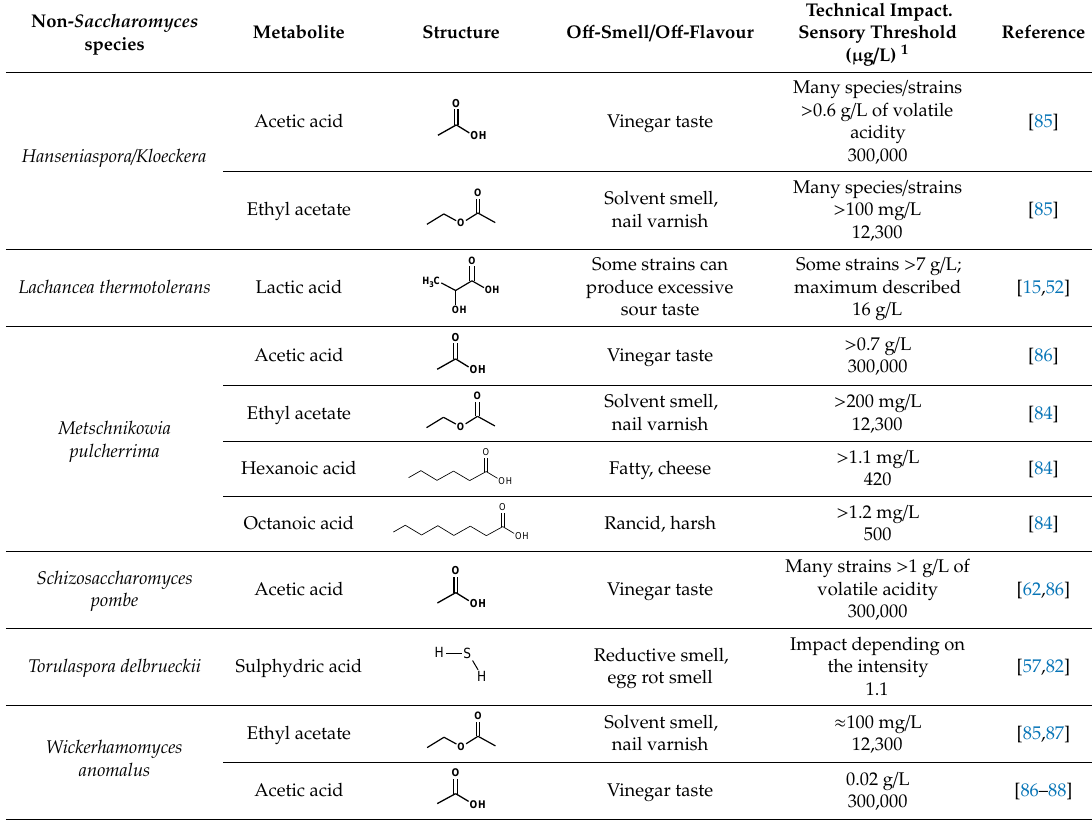
Table 3. Non- Saccharomyces yeast species involved in the production of undesired volatile compounds in wines.